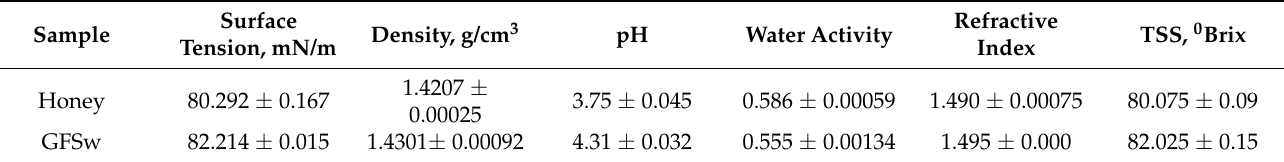
Table 6. Surface tension, density, the pH, water activity refractive index, and total soluble solids (TSS) of honey and GFSw/.